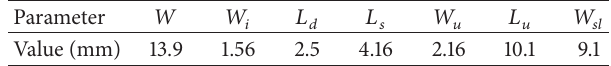
Table 1: Parameters of the proposed